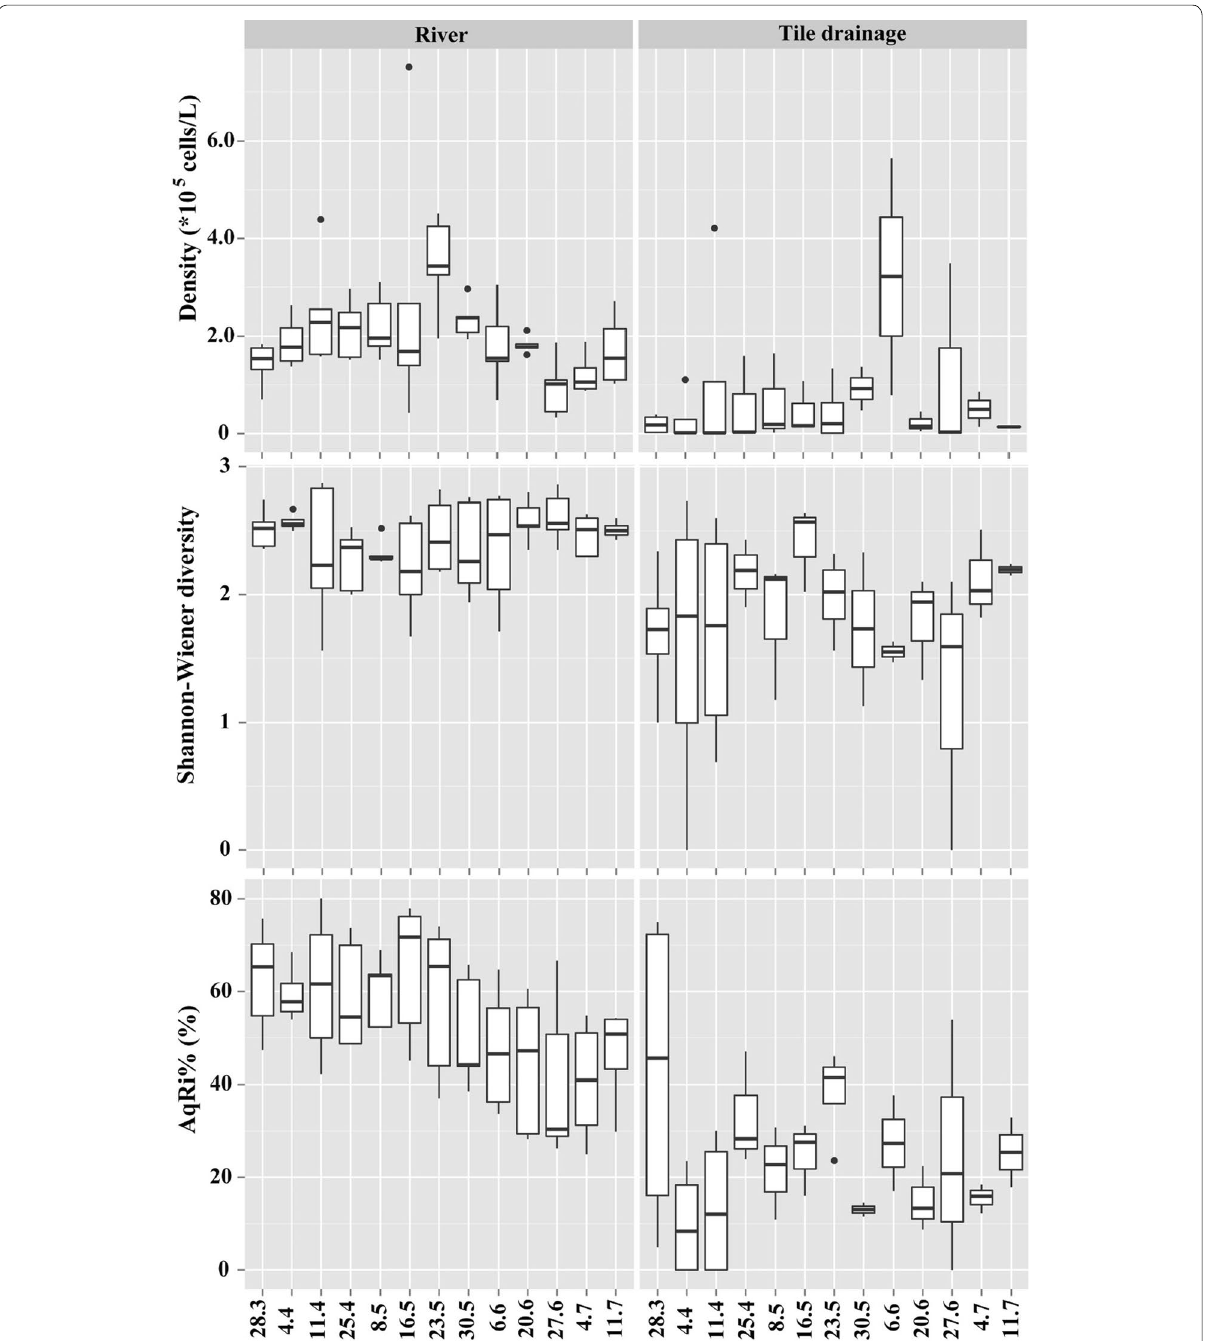
Fig. 5 Temporal variations of different diatom indices at river (Ri) and tile drainage (TD) sites. Boxes show interquartile ranges (25th and 75th percentiles), middle lines are medians, whiskers are non‑outlier ranges beyond the boxes, and dots are outliers. Other diversity indices performed similarly (not